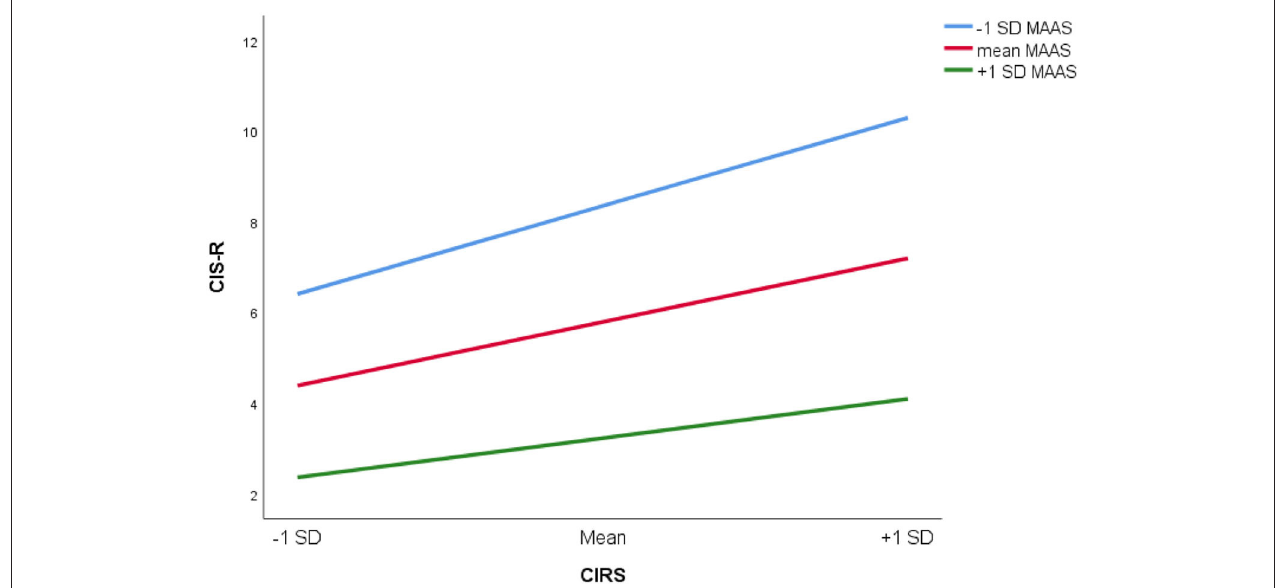
FIGURE 1 | Relationship between CIS-R (Revised Clinical Interview Scale) and CIRS (Cumulative Illness Rating Scale) at MAAS (Mindful Attention Awareness Scale) equal to − 1 SD, mean and + 1